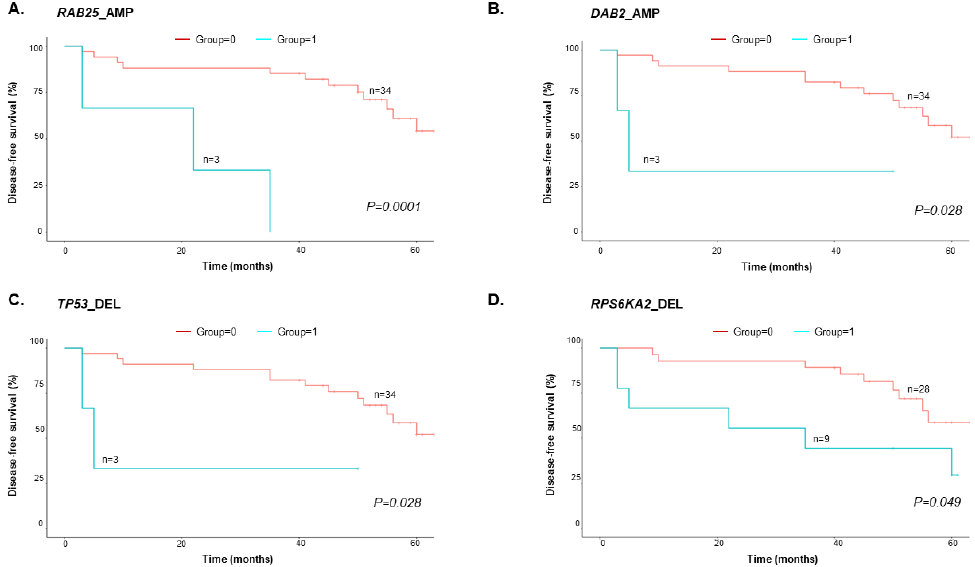
Figure 4. Kaplan–Meier analysis of EOC patient OS (n = 37). ( A ) RAB25 _AMP, ( B ) DAB2_ AMP, ( C ) TP53 _DEL, and ( D ) RPS6KA2_ DEL had significantly worse OS ( p < 0.05, log-rank test).